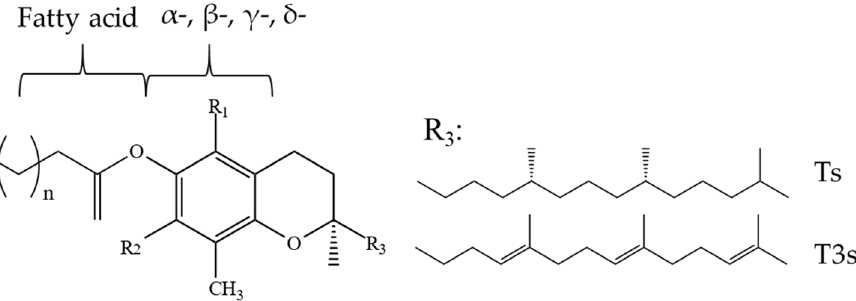
Figure 11. Chemical structure of tocochromanol fatty acid esters. For α-, β-, γ-, δ- methyl substituent number and position see Figure 1.